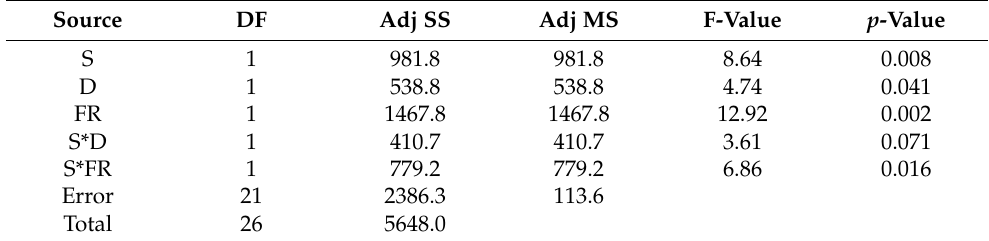
Table 6. ANOVA results for T using conventional cutting edge.